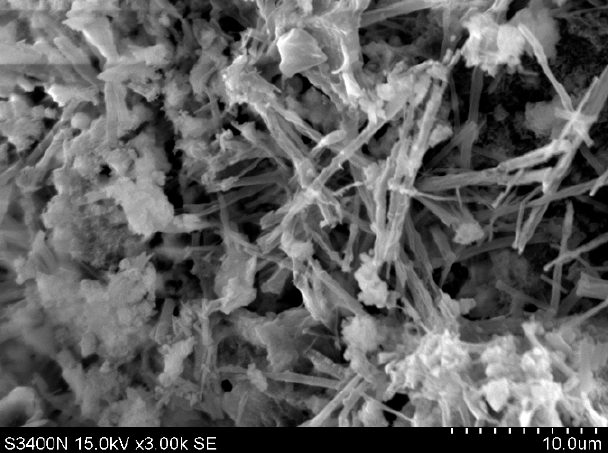
Figure 13. Pore distribution.